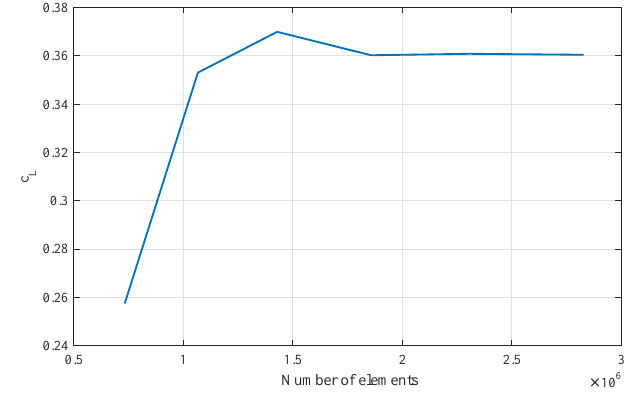
Figure 15. Mesh convergence study for the rigid blade, α = 4 . 0 ◦